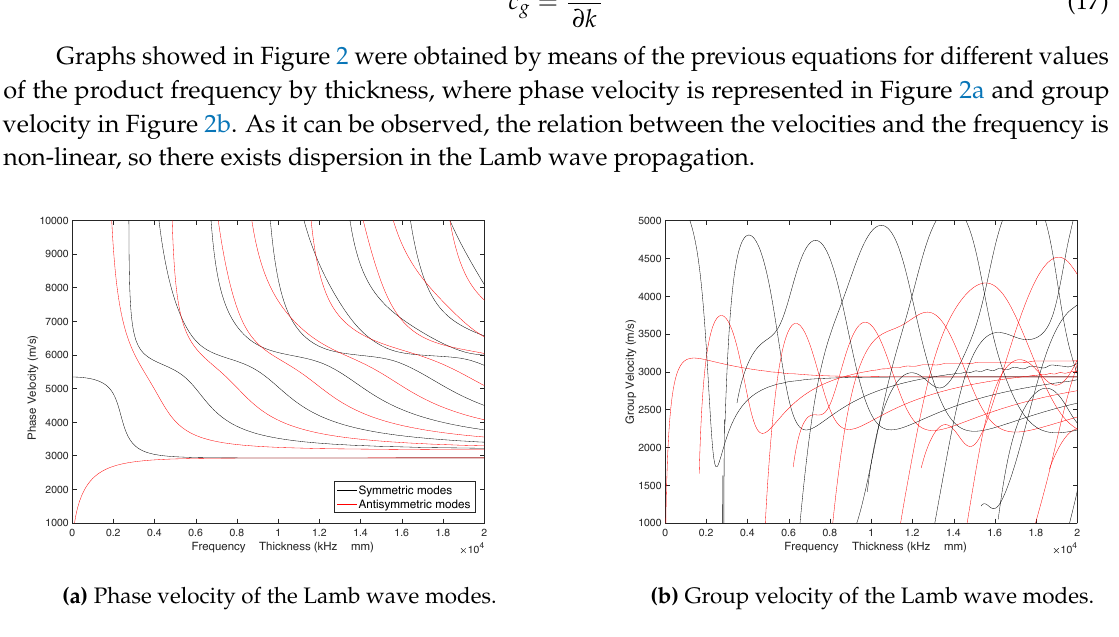
Figure 2. Phase velocity and group velocity depending on the product frequency by thickness. In Figure 2, black lines increasingly represent symmetric modes from left to right (S0, S1, S2...), while red lines represent in the same way antisymmetric modes (A0, A1, A2...). These graphs correspond to a steel pipe with the following parameters: Young’s modulus E = 200 · 10 9 N/m 2 , Poisson’s ratio ν = 0.3 and density ρ = 7700 kg/m 3